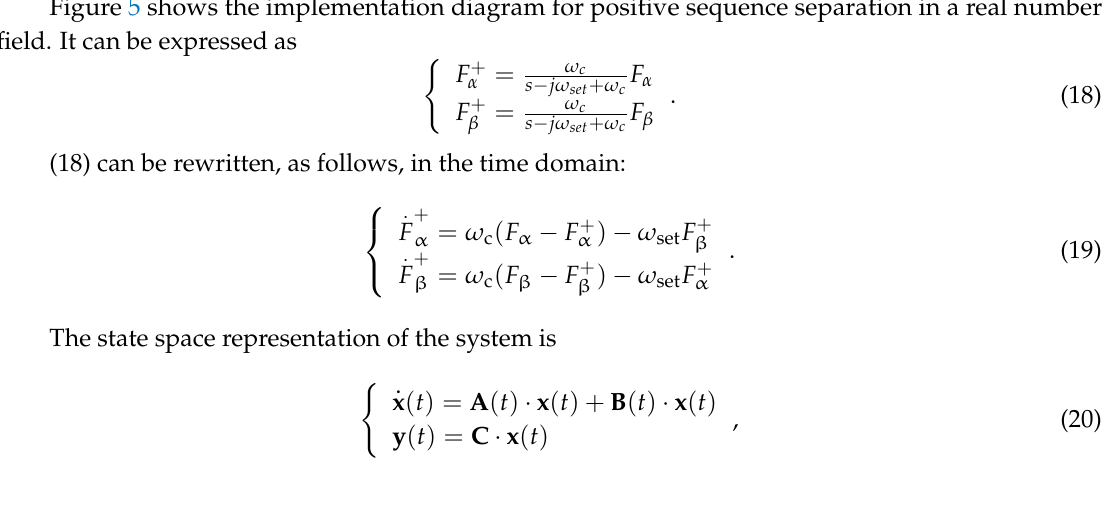
Figure 4. The Bode diagram of the complex component filter ( ω set = 100 π